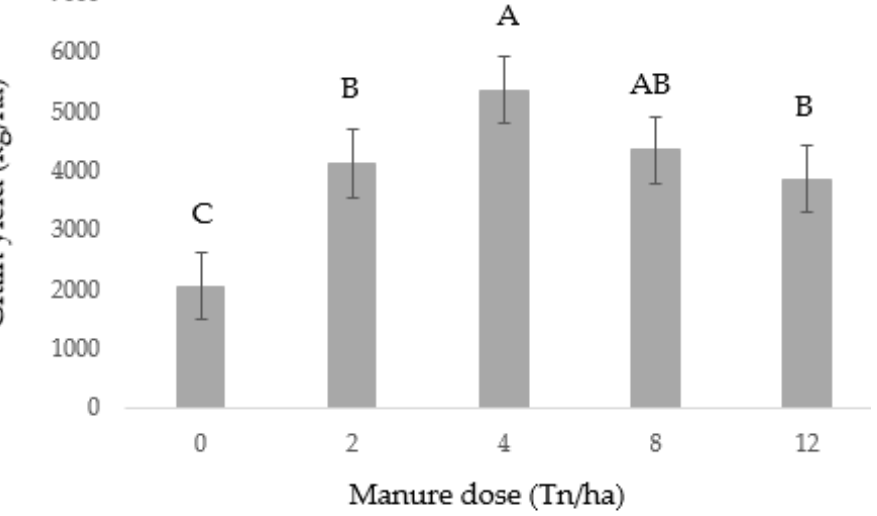
Figure 1. Grain yield (kg/ha) under different doses of goat manure fertilization. Bars show mean ± standard error ( n = 12). Different letters represent significant differences among manure doses at p ≤ 0.05 .